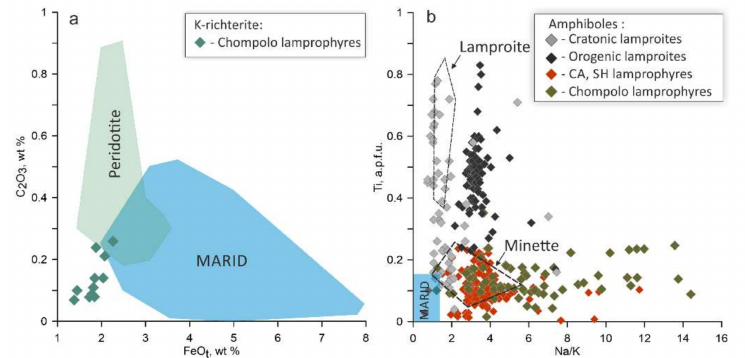
Figure 6. Cr 2 O 3 (wt%) vs. FeO t (wt%) in K-richterite from Aldanskya dyke; fields for